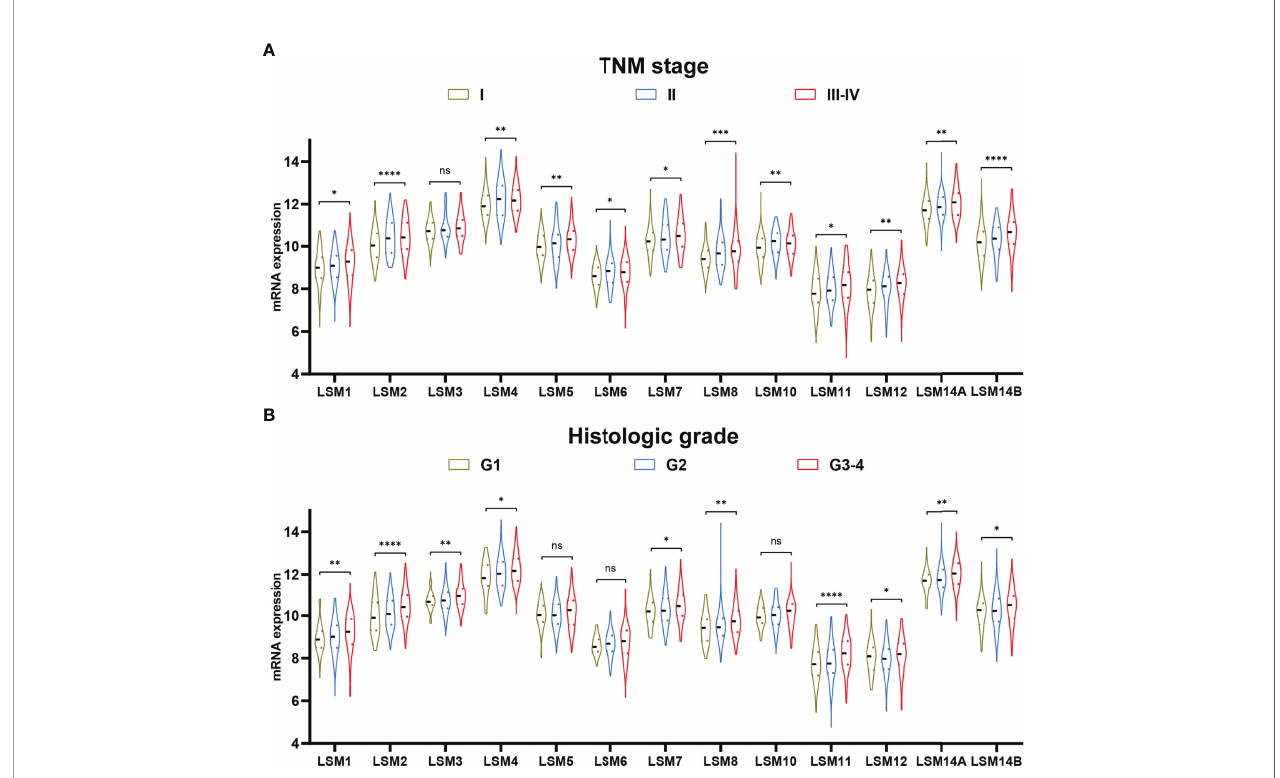
FIGURE 2 | LSM family member expression in TNM stage and histologic grade. (A) Higher expression of LSM1, LSM2, LSM4, LSM5, LSM6, LSM7, LSM8, LSM10, LSM11, LSM12, LSM14A, and LSM14B were observed in tumors with advanced TNM stage. (B) Higher expression of LSM1, LSM2, LSM3, LSM4, LSM7, LSM8, LSM11, LSM12, LSM14A, and LSM14B were also observed in tumors with higher histologic grade. LSM, Smith-like (LSM) family members. ns >0.05; *P-value <0.05; **P-value <0.01; ***P- value <0.001; ****P-value